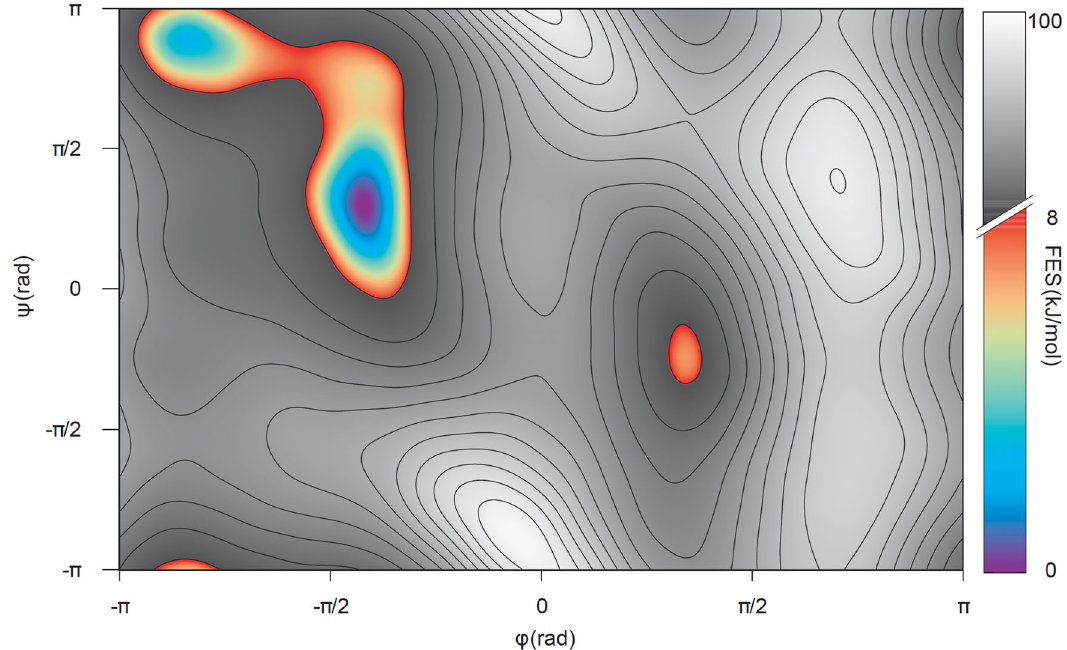
Fig. 2 Free-energy surface for the conformational space of alanine dipeptide. In the color range the interval from 0 to 8 kJ/mol is employed for the threshold. The rest of the surface represents high-energy conformations that have been grayed